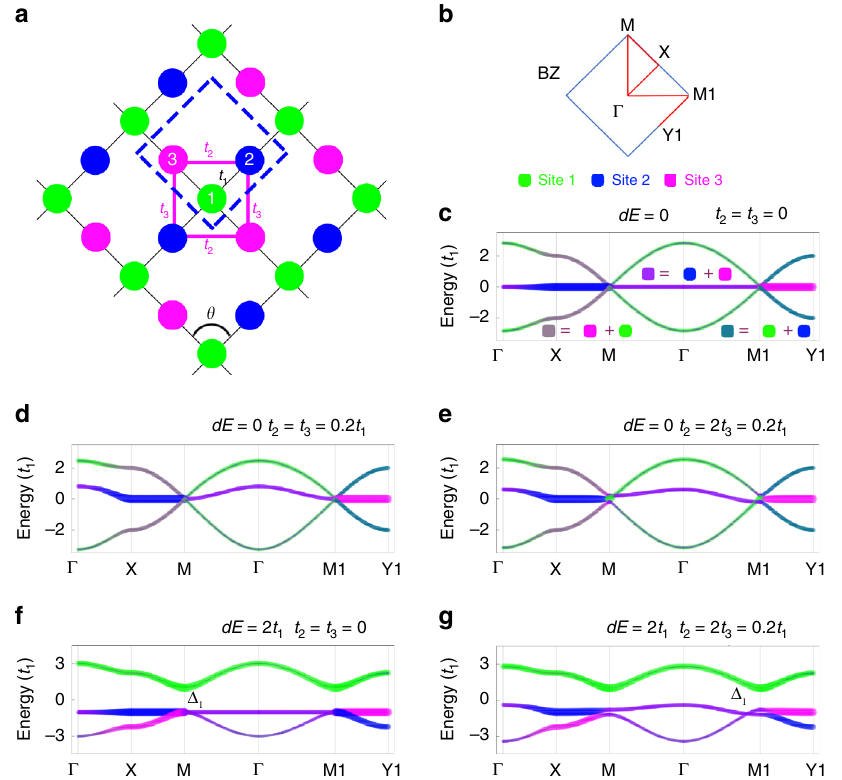
Fig. 1 Three-band Lieb lattice models. a Geometrical structure of a Lieb lattice, which contains one corner site 1 and two edge sites 2 and 3 in the unitcell (marked by the blue dashed-lines). Strength of lattice (geometrical) distortion is indicated by the change of structural angle θ away from 90°. See text for the de fi nitions of other parameters. b Brillouin zone of a Lieb lattice. It notes that M and M1, equal in an ideal Lieb lattice, are inequivalent in a distorted Lieb lattice ( θ ≠ 90° or t 2 ≠ t 3 ). Projected band structures of an ideal Lieb lattice c without and d with NNN hopping. e – g Projected band structures of distorted Lieb lattices under three representative situations. In ( c – g ), the colors of the energy bands represent the wavefunction components from different lattice sites shown in ( a ). Curve width indicates component